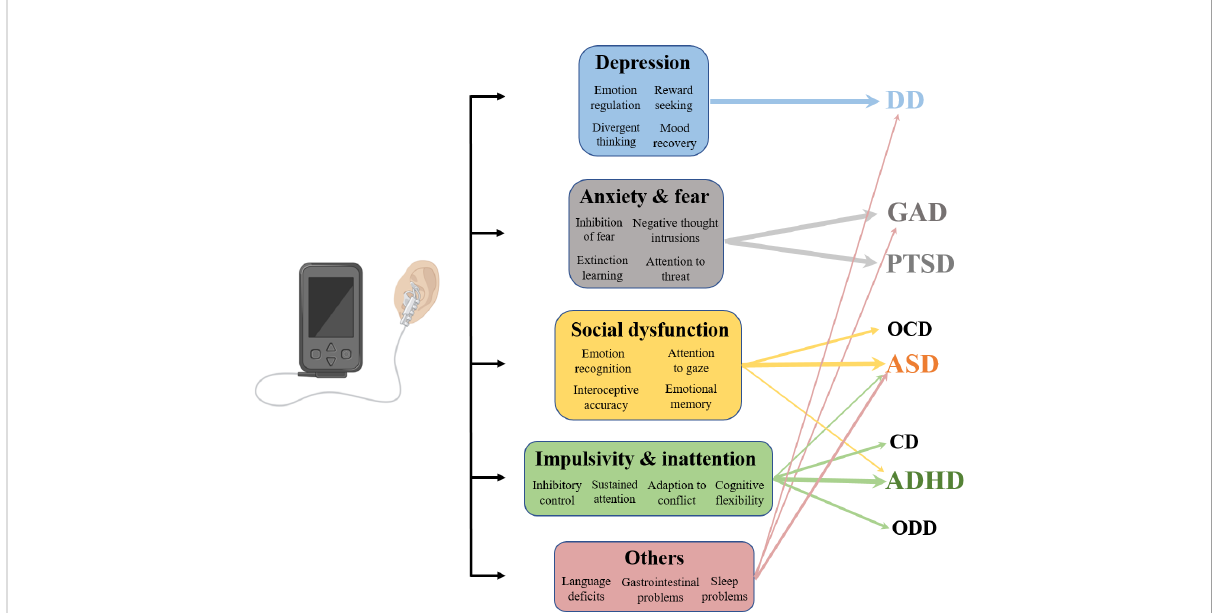
FIGURE 2 Illustration of the potential effects of taVNS on clinical symptoms and corresponding disorders. Depressive disorder (DD), Generalized anxiety disorder (GAD), Post-traumatic stress disorder (PTSD), Obsessive-compulsive disorder (OCD), Autism spectrum disorder (ASD), Conduct disorder (CD), Attention-de fi cit/hyperactivity disorder (ADHD), and Oppositional de fi ant disorder